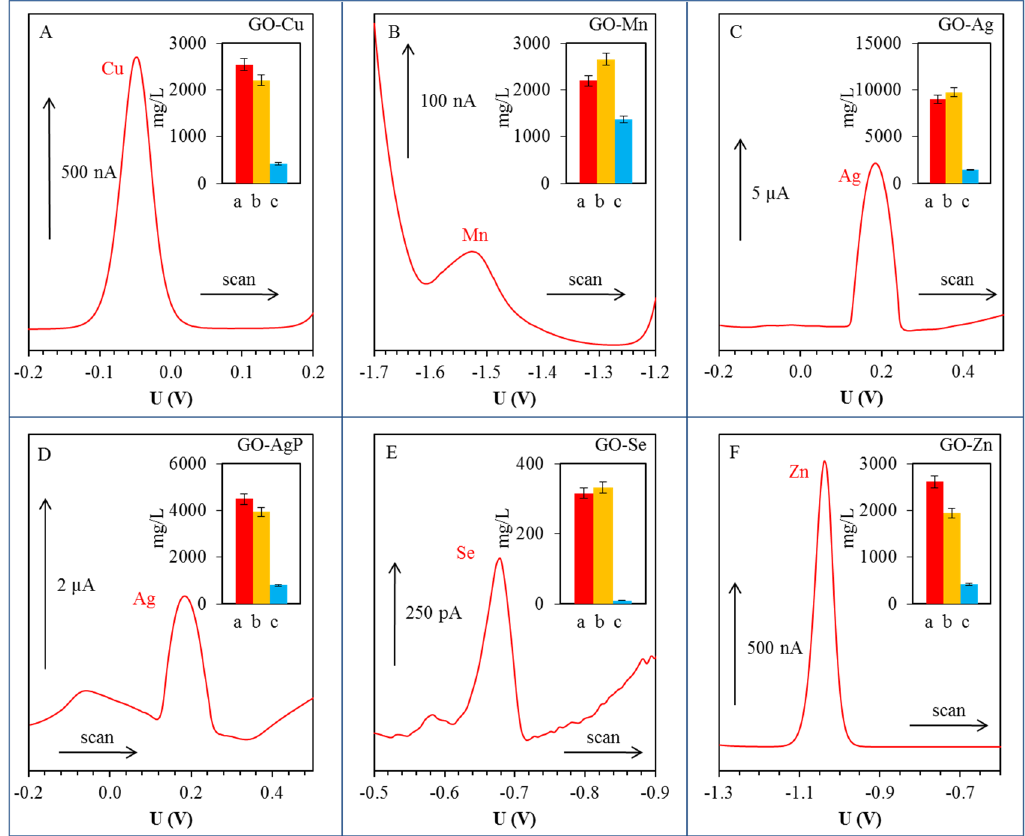
Figure 3. Differential pulse voltammograms of free (non-bonded) metal or metalloid ions